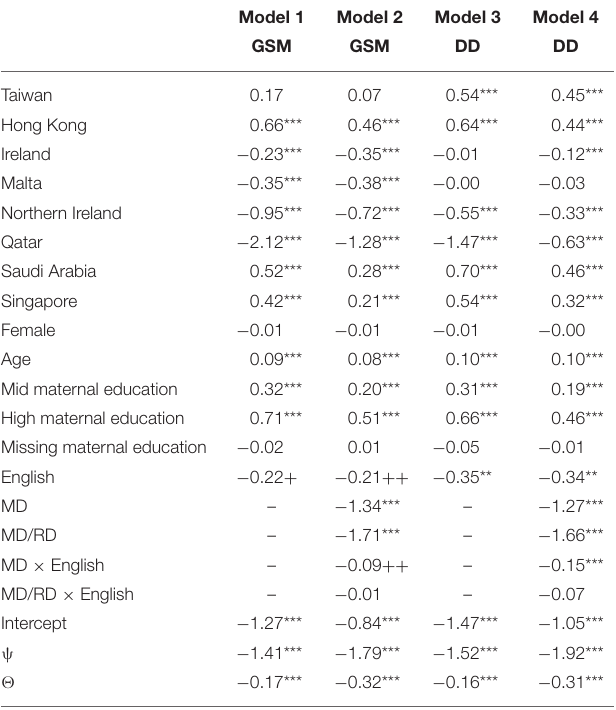
TABLE 3 | Fixed effects estimates and variance-covariance estimates for models of the predictors of fourth-grade mathematics achievement (standardized geometric shapes and data display) on the TIMSS 2011